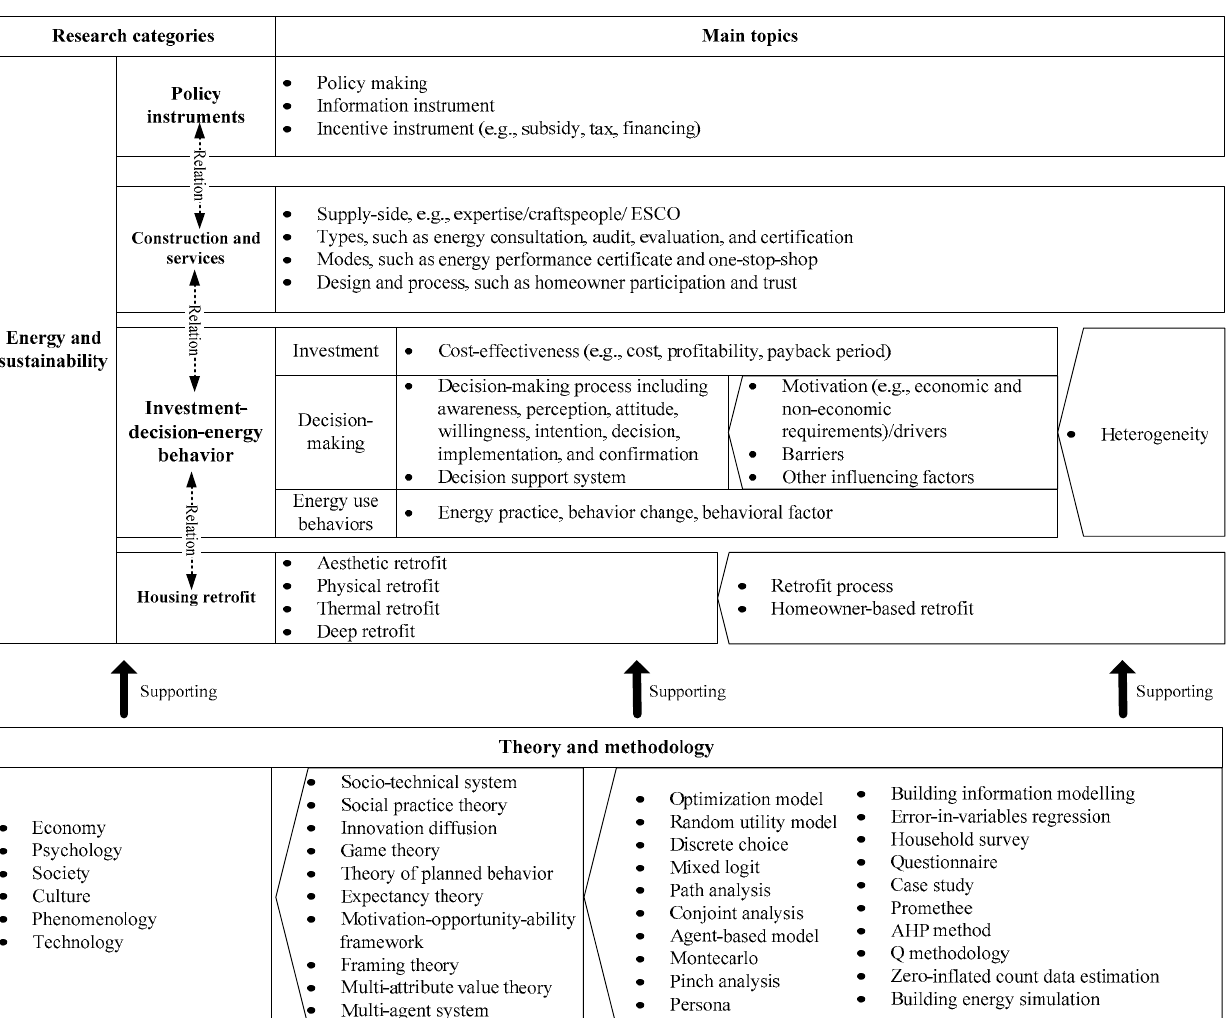
Figure 3. The research map of homeowners’ retrofit behaviors.